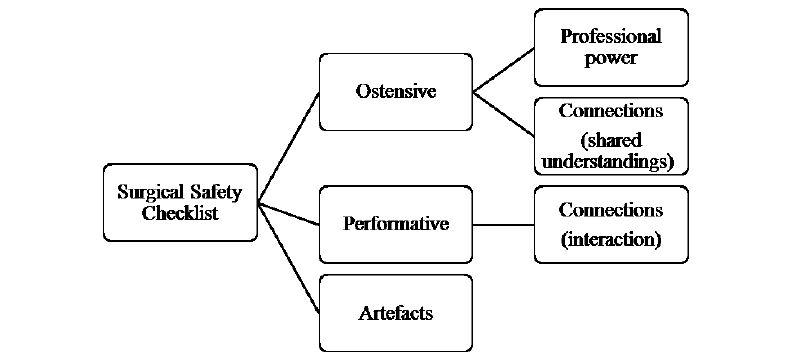
Figure 2. Initial coding